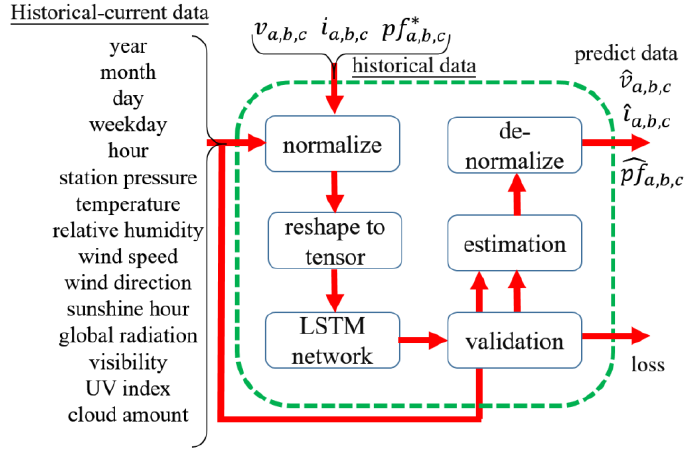
Figure 4. The structure of the proposed LSTM solver.